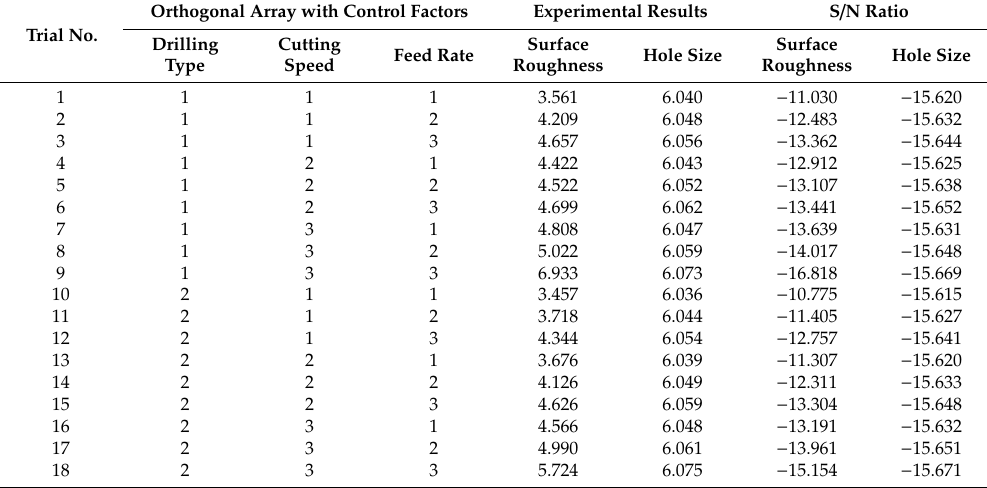
Table 4. Experimental results according to orthogonal array with signal-to-noise (S / N) ratio. Trial No.